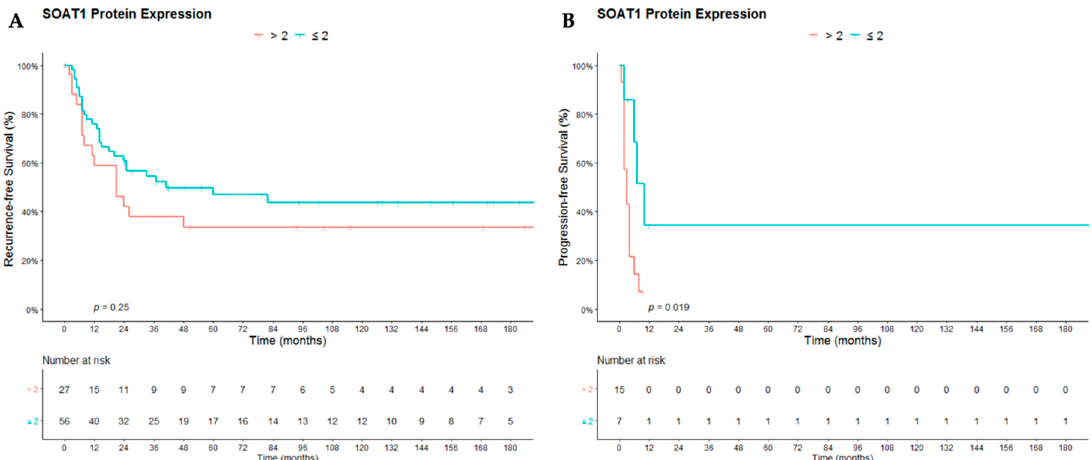
Figure 3. Impact of SOAT1 protein expression on ( A ) recurrence-free survival and ( B ) progression-free survival in adult patients with ACC. For recurrence-free survival analysis, only patients with localized disease at diagnosis who underwent complete resection of the primary tumor (status of resection R0) have been analyzed, and for progression-free survival, only metastatic patients at diagnosis have been analyzed.